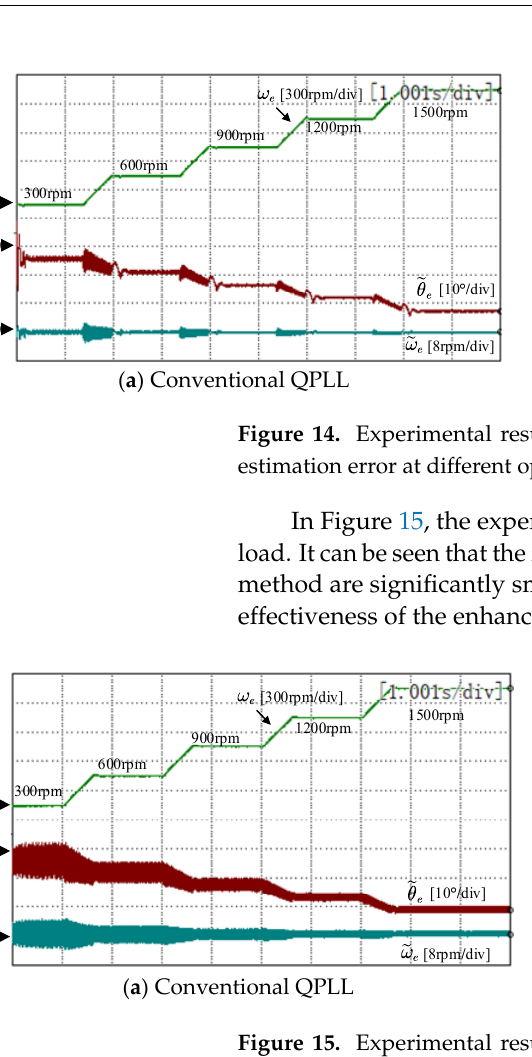
Figure 15. Experimental results of the real speed, the position estimation error, and the speed esti- mation error at different operating speeds under rated load.